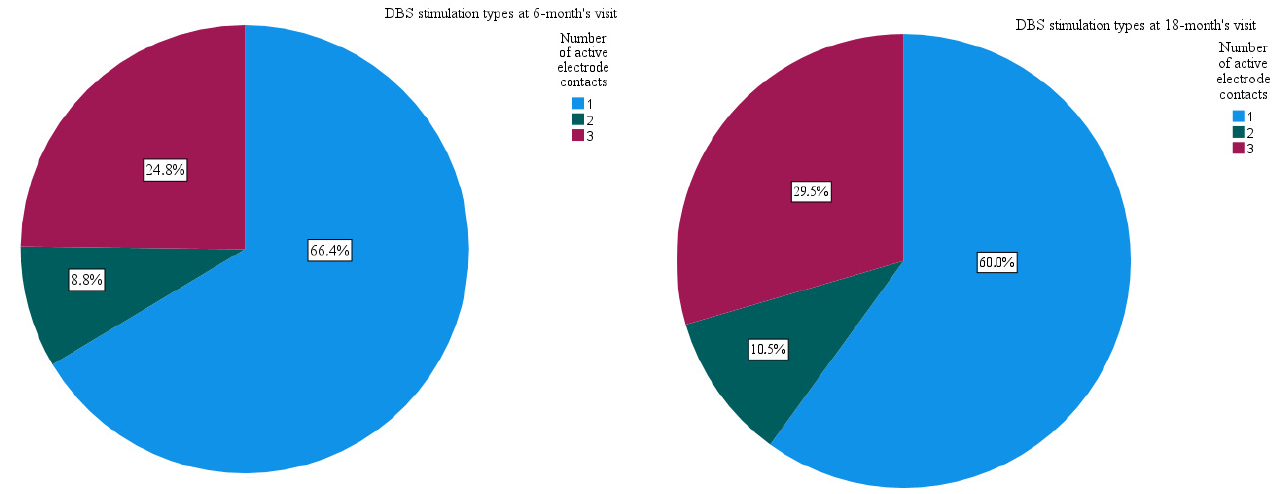
Figure 4. DBS stimulation types in dDBS leads at the 6-month visit and 18-month visit (1 = single segment activation, 2 = two segment activation, 3 = three segment activation/omnipolar stimulation).